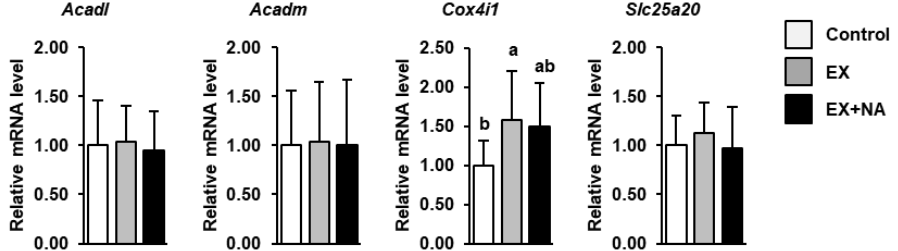
Figure 4. Relative mRNA levels of genes involved in mitochondrial biogenesis- ( A , peroxisome proliferator-activated receptor gamma coactivator 1 alpha ( Ppargc1a )) and genes encoding mitochondrial enzymes ( B , acyl-CoA dehydrogenase long chain ( Acadl ); acyl-CoA dehydrogenase medium chain ( Acadm ); cytochrome c oxidase subunit 4I1 ( Cox4i1 ); solute carrier family 25 member 20 ( Slc25a20 )) in gastrocnemius muscle of sedentary mice fed an NA adequate diet (Control) and mice subjected to regular endurance exercise fed either an NA adequate diet (EX) or a high NA diet (EX + NA) for 6 weeks. Bars represent means ± SD for n = 10 animals per group. Relative mRNA levels are expressed as fold of Control (= 1.0). Bars without a common lowercase letter (a, b) differ, P < 0.05.